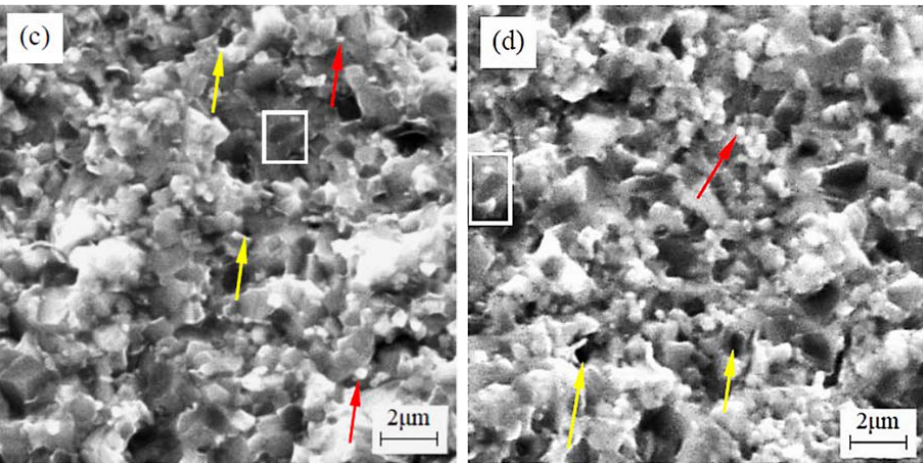
Figure 4. Fracture morphologies of TiC 0.7 N 0.3 ‐ HfC ‐ WC ‐ Ni ‐ Mo cermet tool materials with different WC